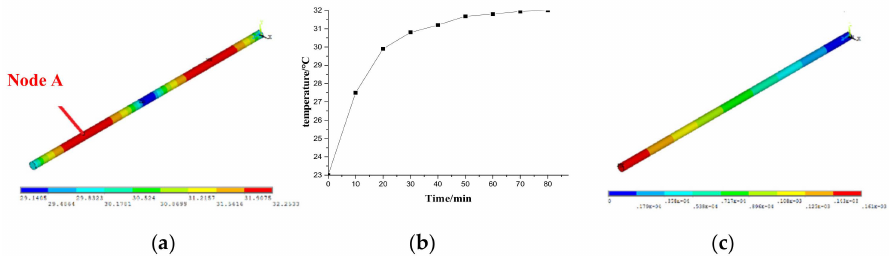
Figure 7. FE results of the ball screw. ( a ) Steady-state temperature field; ( b ) Temperature curve of Node A; ( c ) Displacement